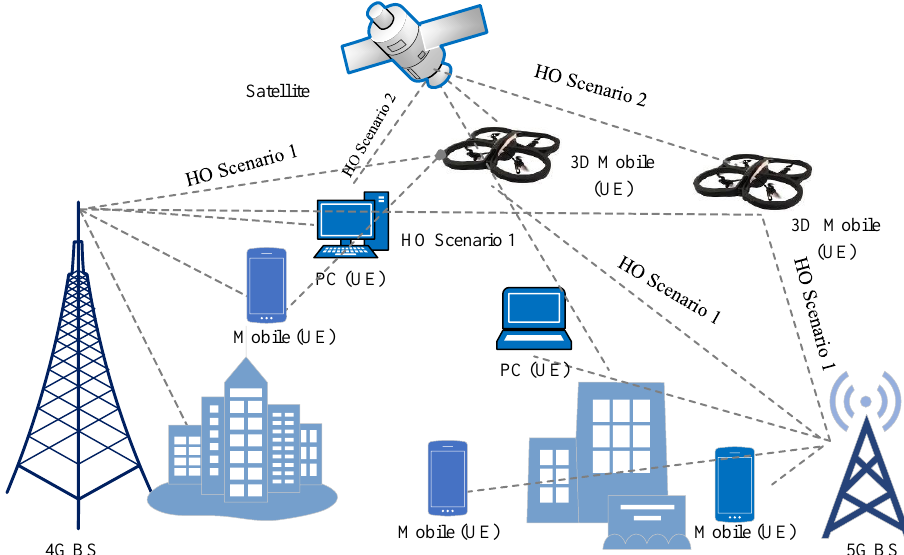
Figure 8. HO for UAVs as normal users in a future ultra – dense heterogenous network.